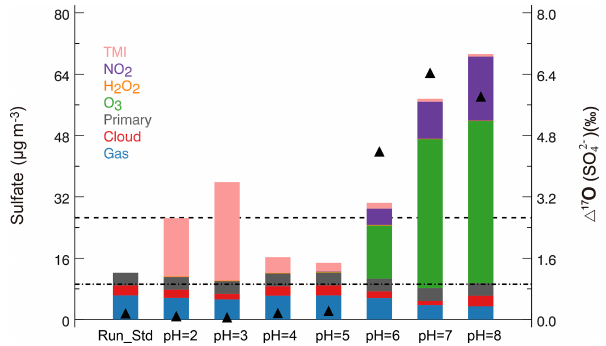
Figure 5. Model-simulated mean sulfate concentration in Beijing averaged over heavy pollution periods (HPP, as defined in the text). Model results are from the standard simulation (Run_Std) and sen- sitivity simulations with prescribed aerosol pH ranging from 2 to 8. Different colors represent contributions from different sulfate for- mation pathways, including four heterogeneous reactions: oxidation by O 2 (TMI), NO 2 , H 2 O 2 , O 3 ; primary anthropogenic, aqueous- phase oxidation in clouds; and gas-phase oxidation. Also shown are the corresponding modeled (cid:49) 17 O(SO 2 − ) values in Beijing (black 4 triangles). The dashed line denotes observed mean sulfate concen- tration (25.9µgm − 3 ), and the dotted, dashed line denotes observed mean (cid:49) 17 O(SO 2 − ) (0.9‰) during HPP in Beijing. 4